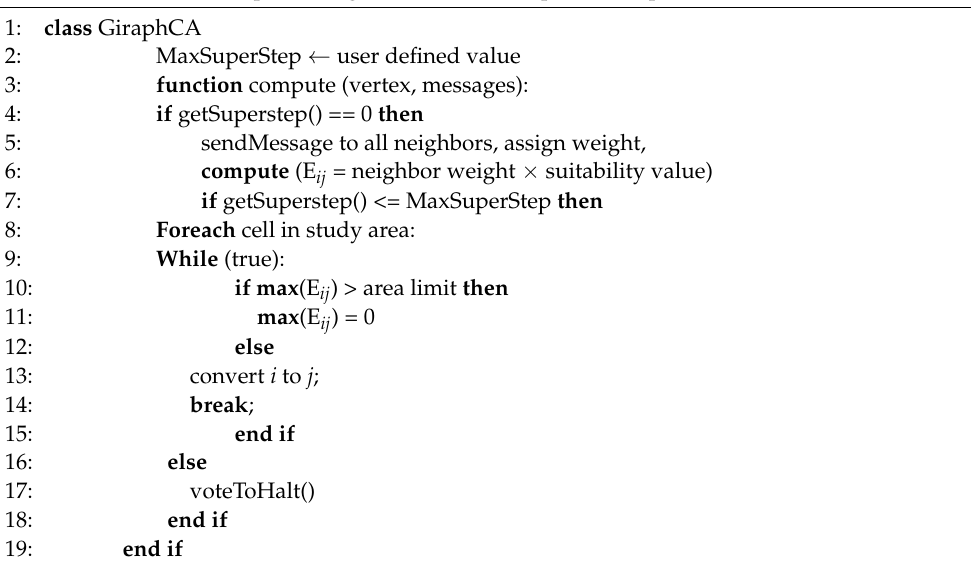
Algorithm 2 Distributed processing CA model with Apache